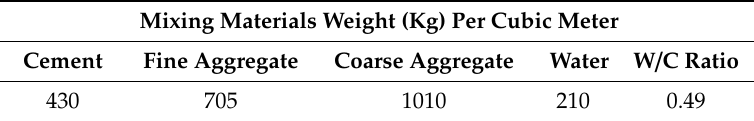
Table 1. Concrete mix proportions.